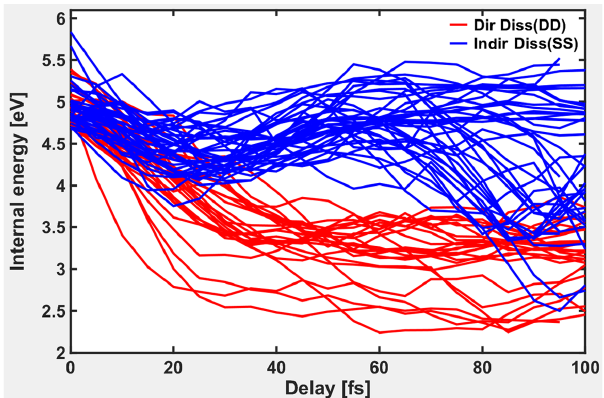
FIG. 13. Calculated energies as a function of time for individual trajectories in the first 100 fs. Each individual line represents a single trajectory. Direct and indirect trajectories are plotted in red and blue, respectively. DD represents direct dissociation, and SS represents the symmetric stretch associated with indirect